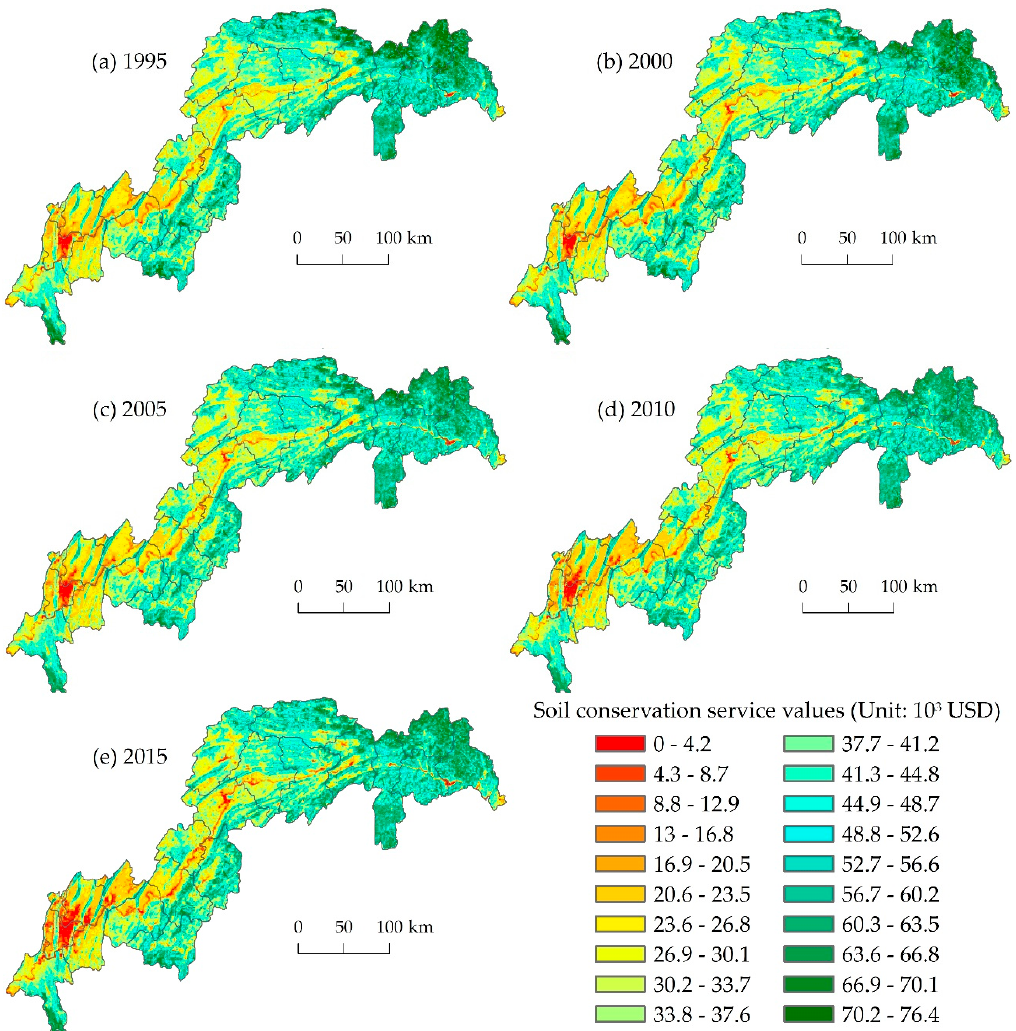
Figure 5. Soil conservation service values (SCSV) of the Three Gorges Reservoir Area for ( a ) 1995, ( b ) 2000, ( c ) 2005, ( d ) 2010, and ( e ) 2015; their respective total SCSVs are 2.447, 2.441, 2.444, 2.440, and 2.424 billion USD.